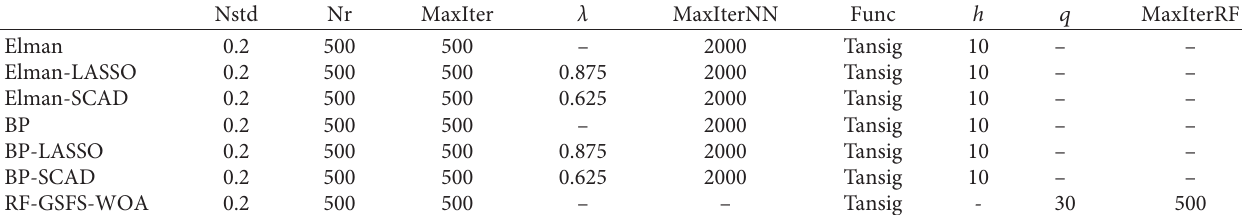
Table 2: Important parameters of seven forecasting models.